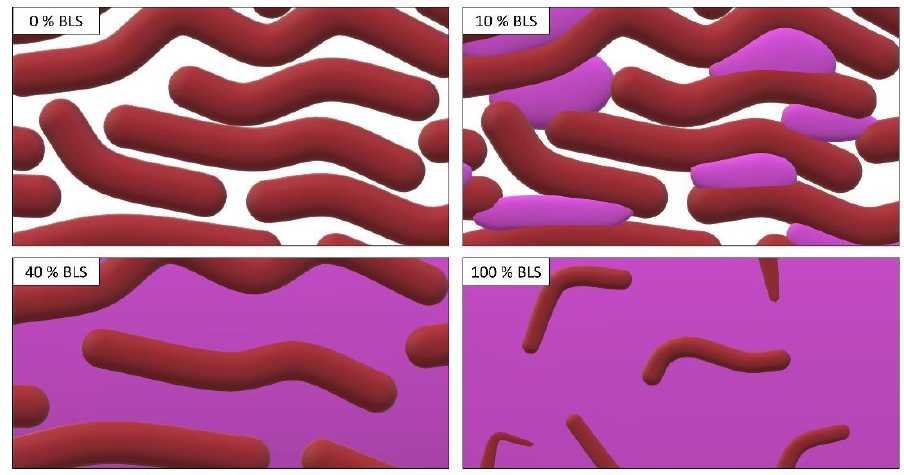
Figure 3. Mechanistic illustration of the meat fibers (brown elongated structures) interacting with the binding BLS (purple matter). Captions in the upper left corner correspond to the amount of BLS.